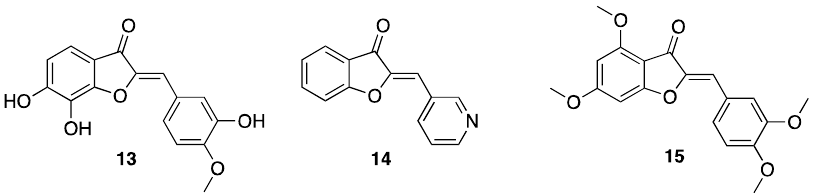
Figure 4. Representative natural and synthetic antifungal aurones.